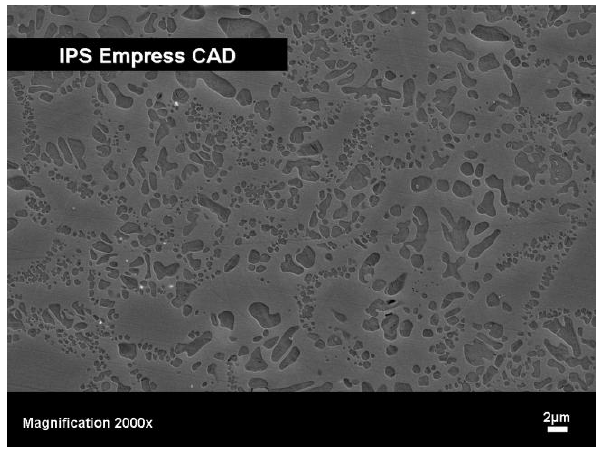
Figure 1. SEM image of a leucite-type glass-ceramic (IPS Empress  CAD, Ivoclar Vivadent AG), fracture surface etched with 3% HF for 10